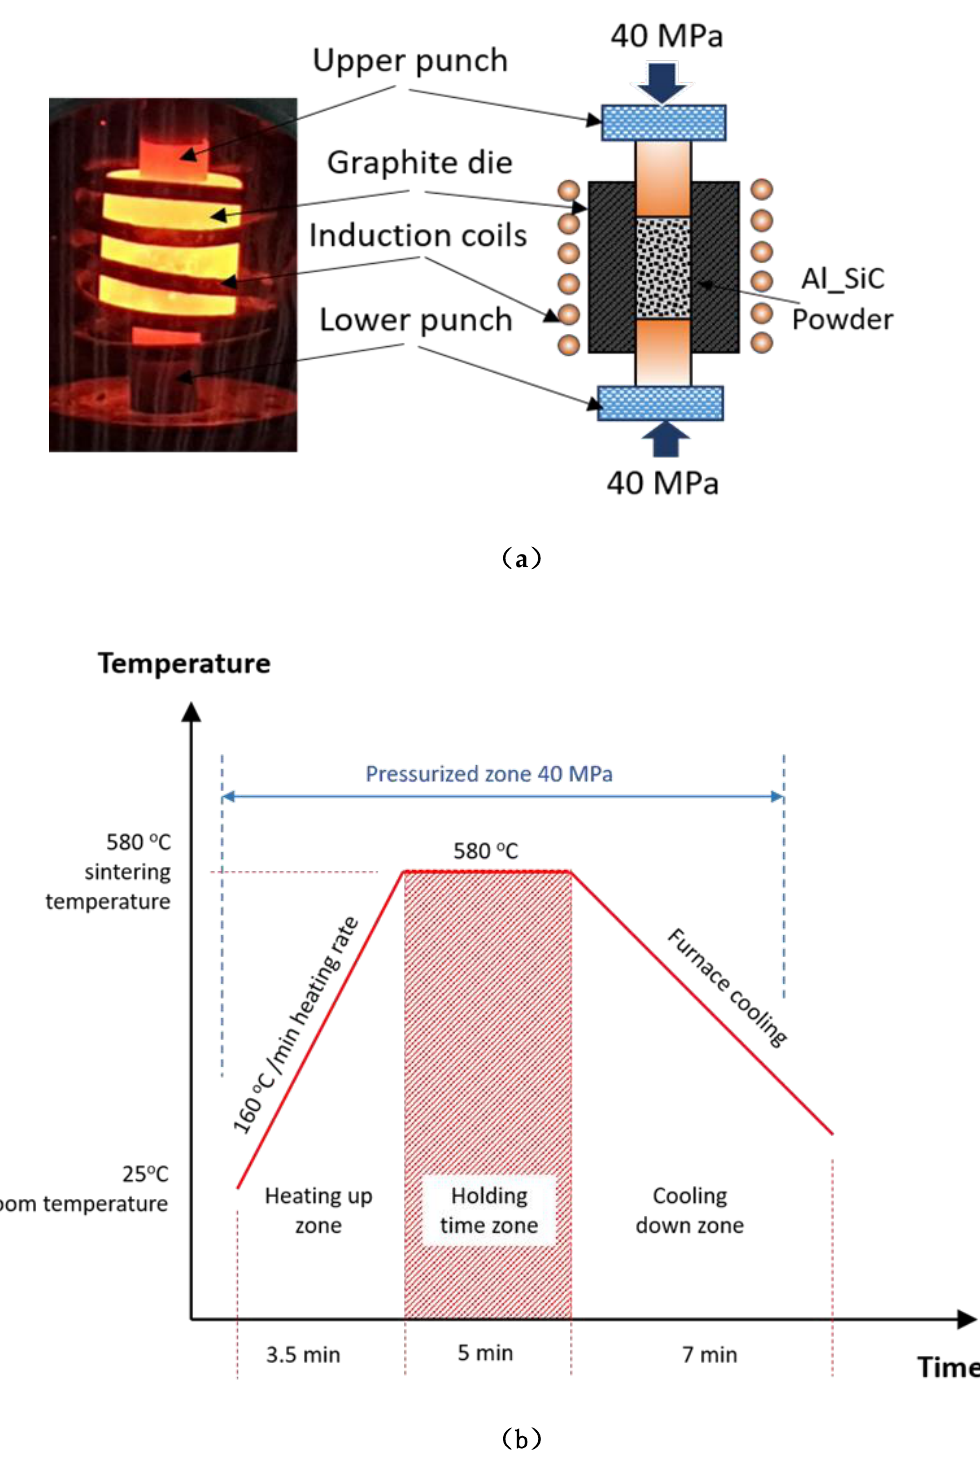
Figure 3. ( a ) Graphite die used in the consolidation process, and ( b ) high-frequency induction sintering process diagram.